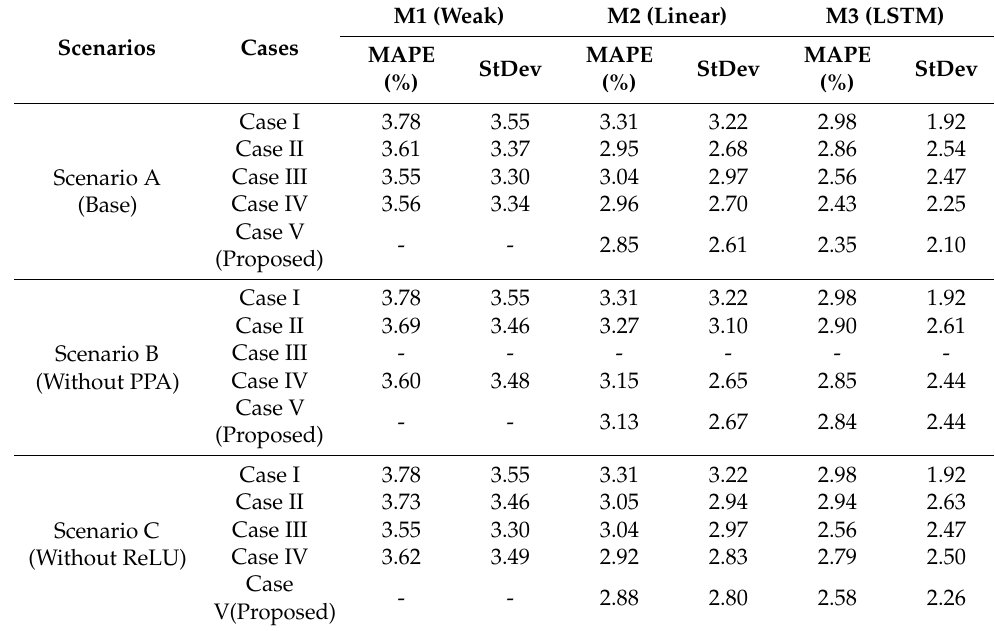
Table 6. Comparison of Day-Ahead Load Forecast Error for Cases by Applying BTM Methods based on Three Different